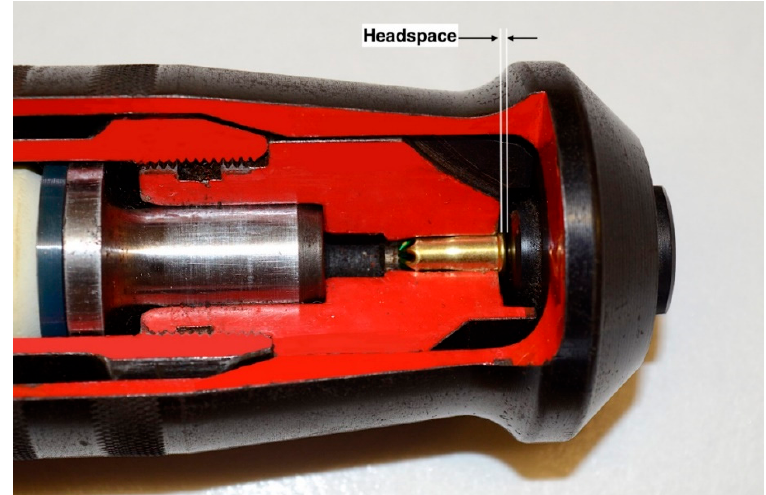
Figure 6. The headspace is the distance between the cartridge and the firing pin block (cross sectional model of an Accles and Shelvoke ‘Cowpuncher’ 5413R 0.22 ″ calibre contact firing penetrating captive bolt device).